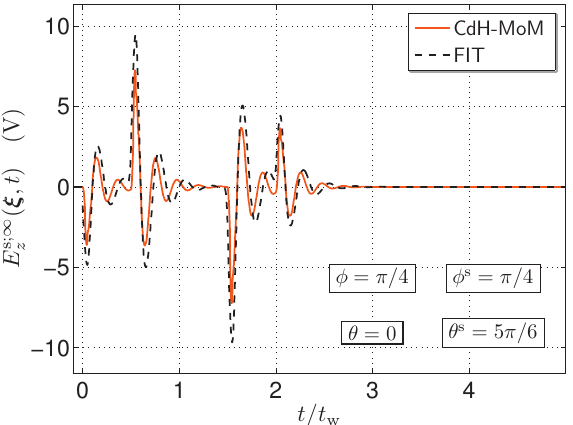
Figure 5. Electric far-field amplitude behind the